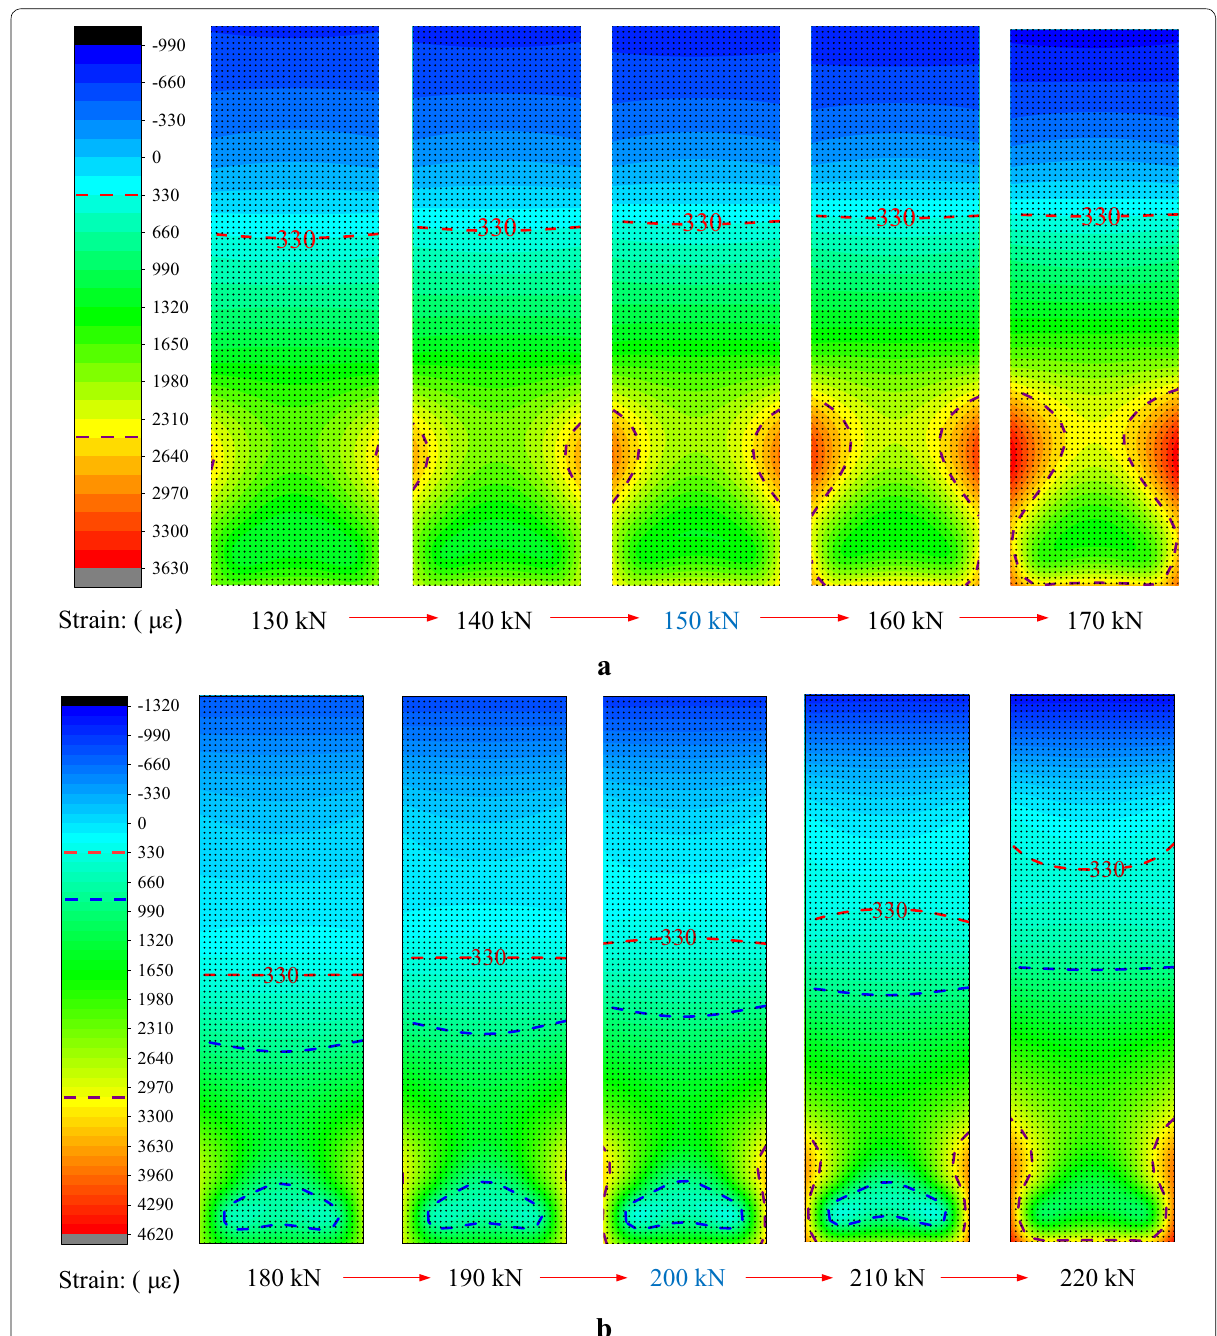
Fig. 19 The strain fields of the RC beams with different reinforcement ratio around characteristic loads Q : a the strain fields of the contrast beam (B1); b the strain fields of CFRP-strengthened beam B3; c the strain fields of CFRP-strengthened beam B4; d the strain fields of CFRP-strengthened beam